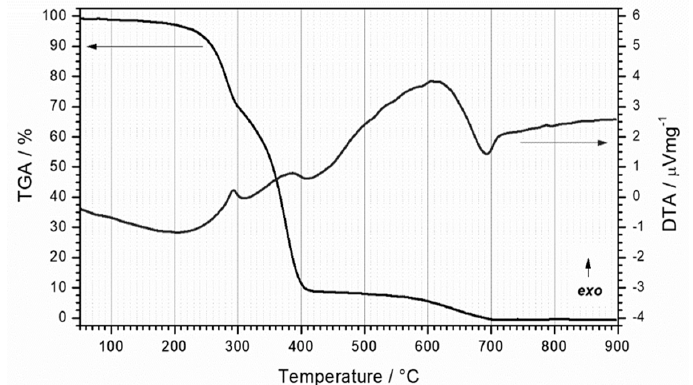
Figure 3. Differential Thermal Analysis (DTA) and Thermo-Gravimetric Analysis (TGA) curves of the 30 pores per inch (ppi) PU foam.